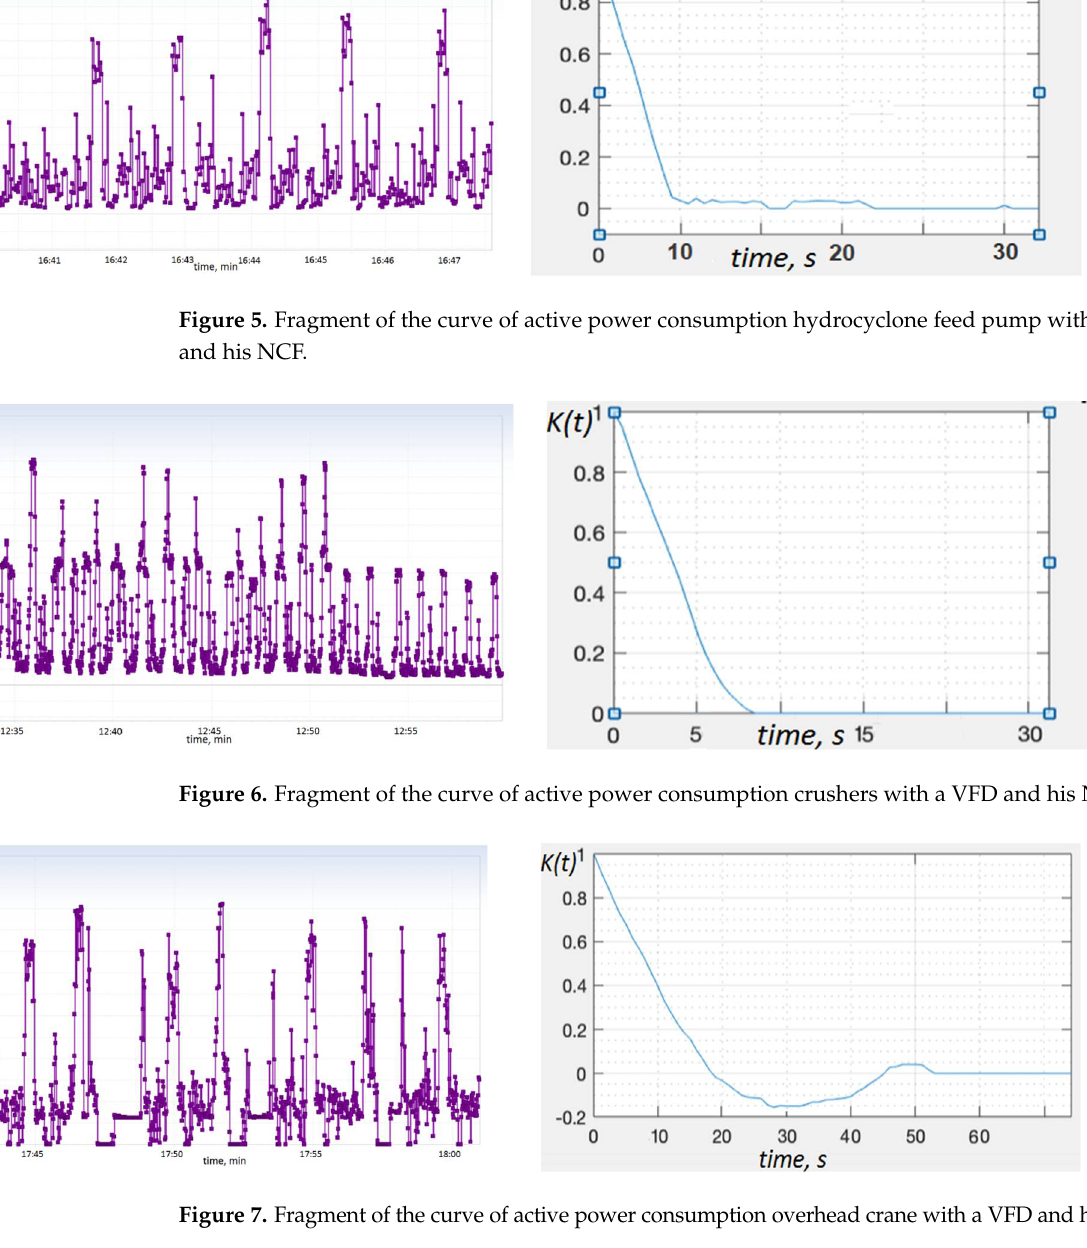
Figure 8. Fragment of the curve of active power consumption pneumatic–mechanical flotation tank cells without a VFD and his NCF. Table 9. Parameters of the various types of NCFs, with and without the use of a frequency converter. Electric Drive Name